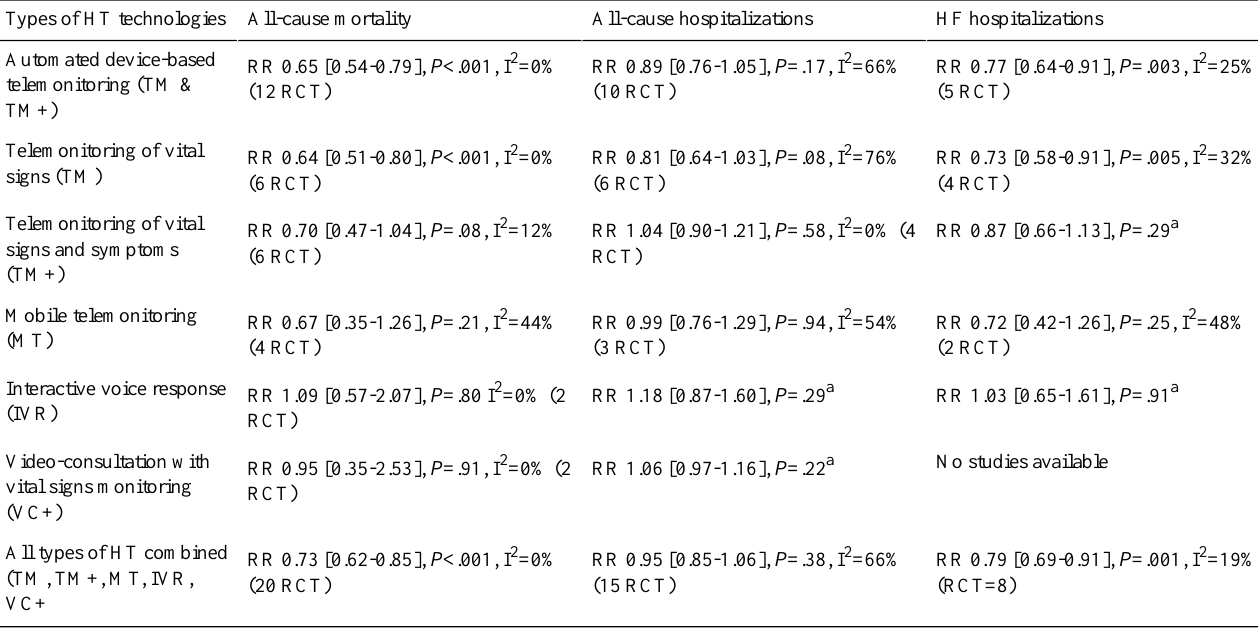
Table 10. Effects of HT according to the type of technology